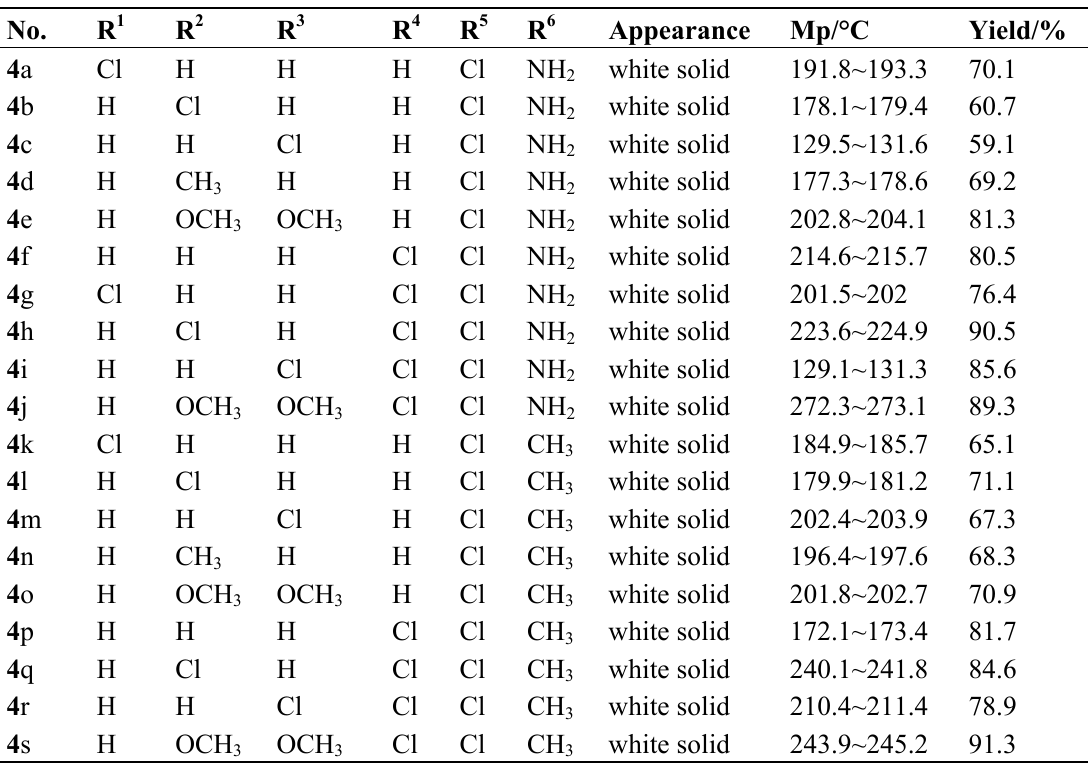
Table 5. Molecular structures, yields, and melting points of synthesized 2-phenoxy-3 H - quinazolin-4-ones 4